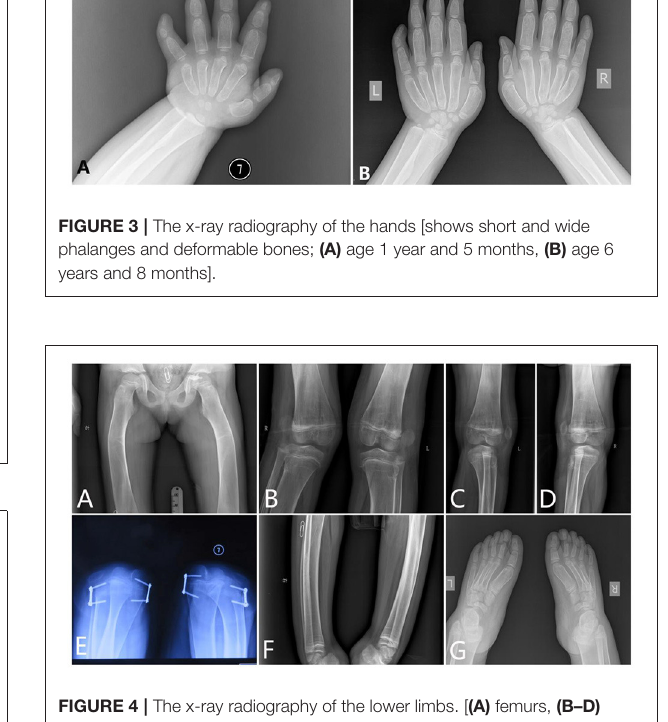
FIGURE 4 | The x-ray radiography of the lower limbs. [ (A) femurs, (B–D) knees, (E) shows lateral dislocation of the patella, (F) tibia, and (G) feet].